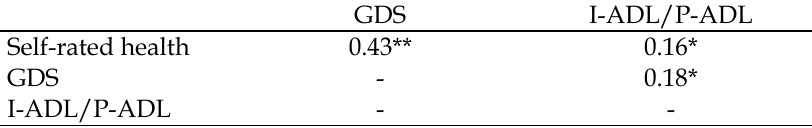
Table 5. Correlations between all predictors,